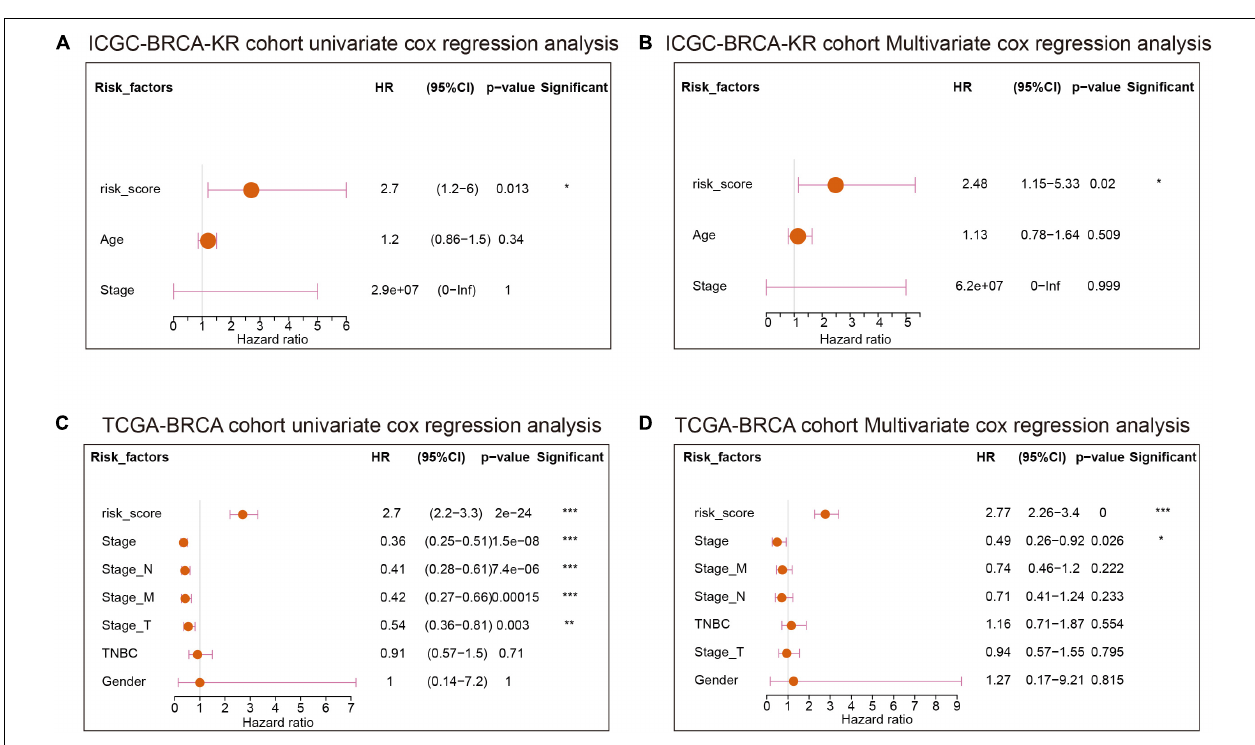
FIGURE 5 | The efficiency and stability evaluation of GVRM. (A,B) Kaplan–Meier curve showed the overall survival in patients with high and low risk in age subgroups ( p < 0.0001 and p < 0.0001, respectively). (C,D) Kaplan–Meier curve showed the overall survival in patients with high and low risk in stage subgroups ( p < 0.001 and p < 0.001, respectively). (E,F) Kaplan–Meier curve showed the overall survival in patients with high and low risk in stage_M subgroups ( p < 0.001 and p = 0.092, respectively). (G,H) Kaplan–Meier curve showed the overall survival in patients with high and low risk in stage_N subgroups ( p < 0.001 and p = 0.015, respectively). (I,J) Kaplan–Meier curve showed the overall survival in patients with high and low risk in stage_T subgroups ( p < 0.001 and p = 0.006, respectively).